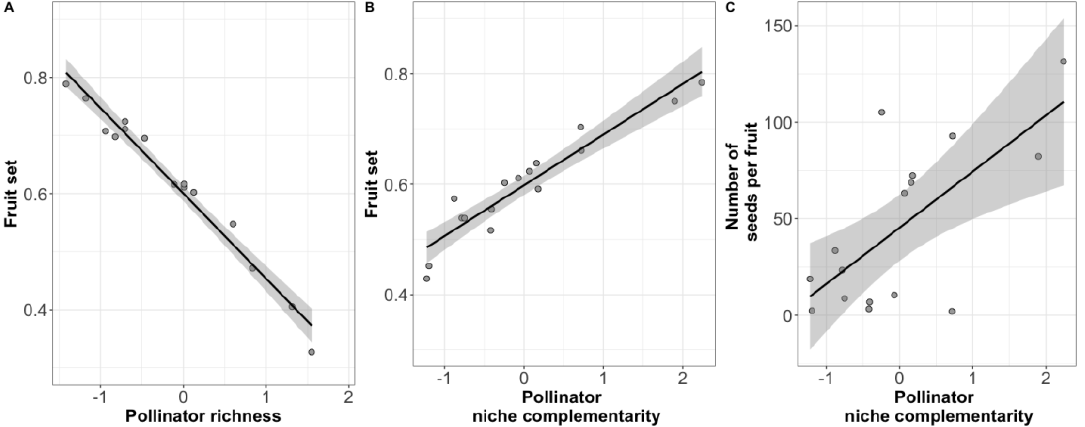
Figure 2. Partial residual plots showing the effect of the single predictor which best explains the variability in site-level reproductive success. A) Shows the effect of pollinator richness, and B) of niche complementarity among pollinator species on site-level average fruit set. C) Shows the effect of niche complementarity among pollinator species on the average number of seeds per fruit at the site level. Dots represent average values of fruit set at the level of the community for all plant species considered (N=16